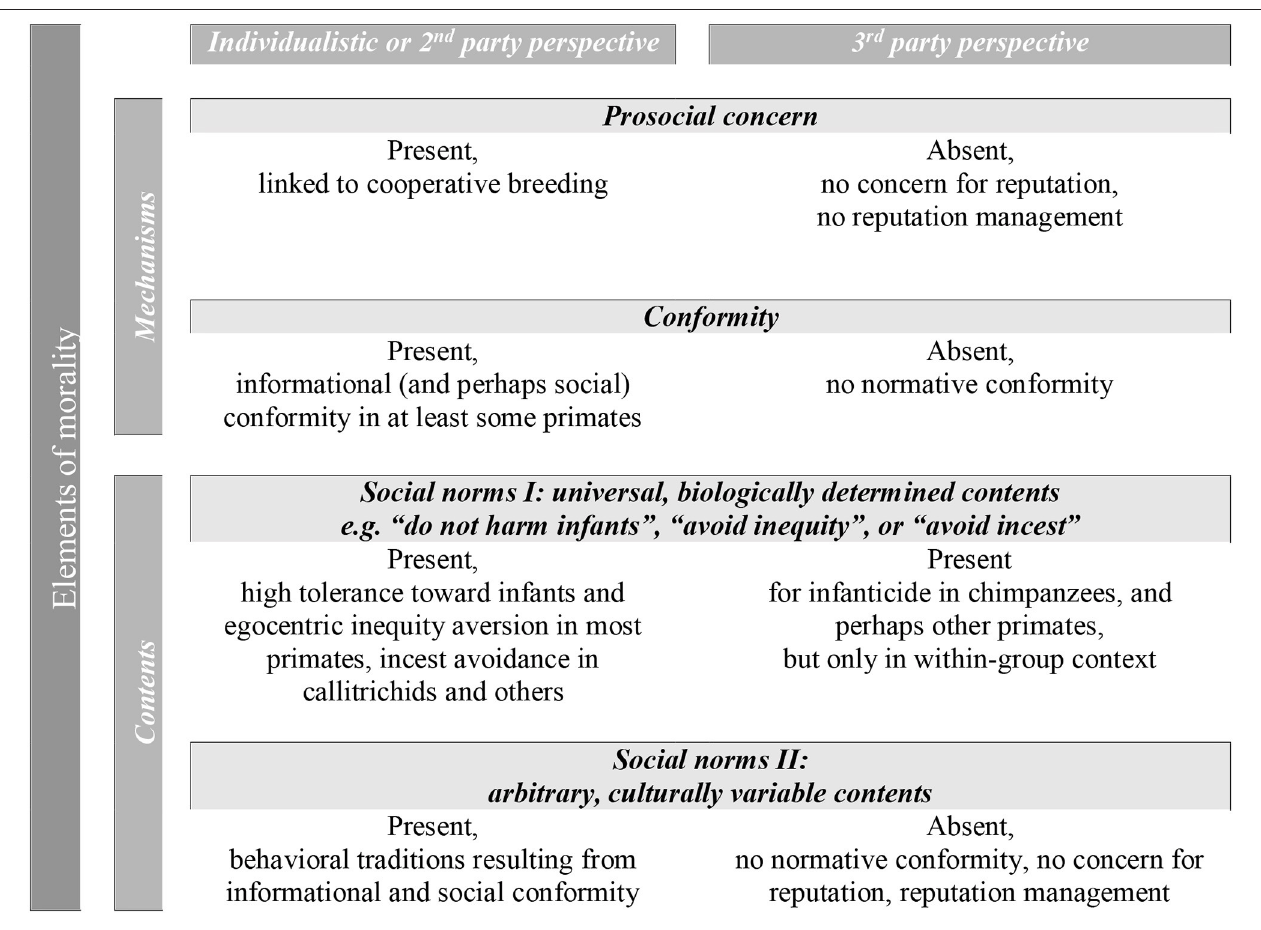
FIGURE 1 | The presence of elements of morality in non-human